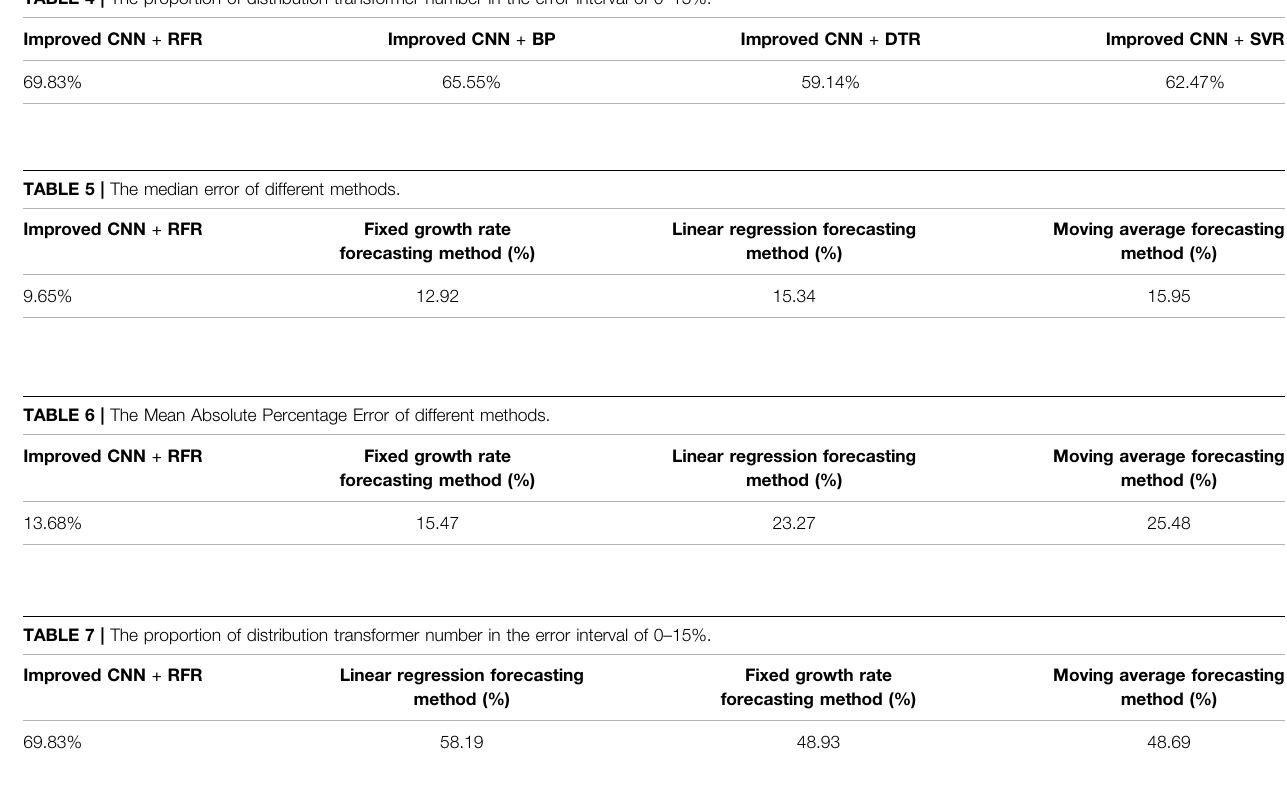
TABLE 4 | The proportion of distribution transformer number in the error interval of 0 – 15%.